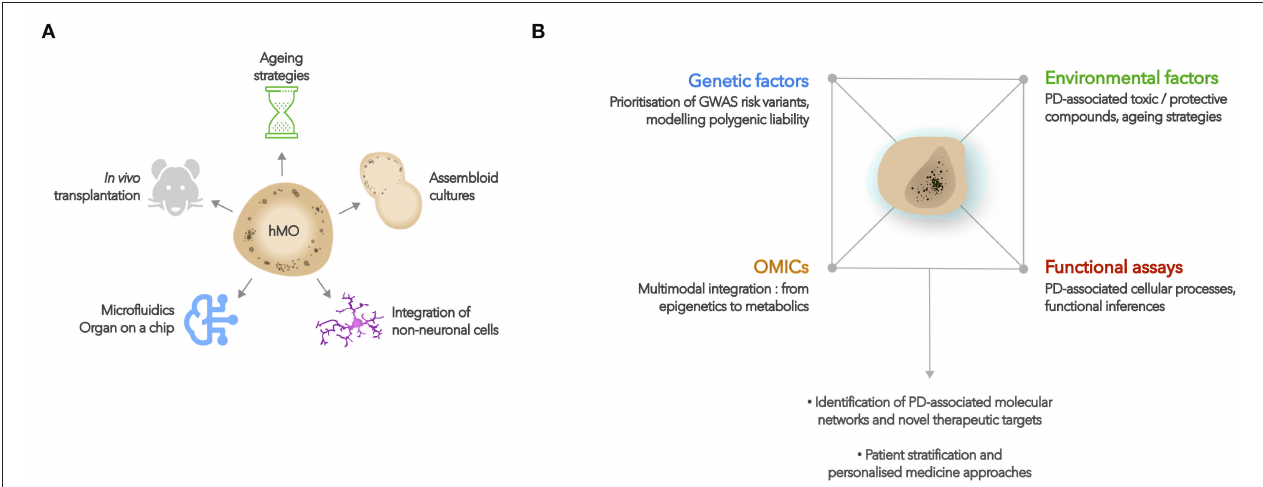
FIGURE 2 | Developments and applications of hMO cultures. (A) Potential developments of hMO cultures include aging strategies, fusions with other brain region organoids, co-cultures with non-neuronal lineage cells (such as microglia, endothelial cells), use of microfluidics or “organ on a chip” approaches, and in vivo transplantations. (B) hMO constitute relevant biological platforms to study the effects of PD-associated genetic and environmental factors on cellular function and molecular networks. Such approaches may lead to a better understanding of the molecular basis of PD, help identify new therapeutic targets, and develop personalized medicine